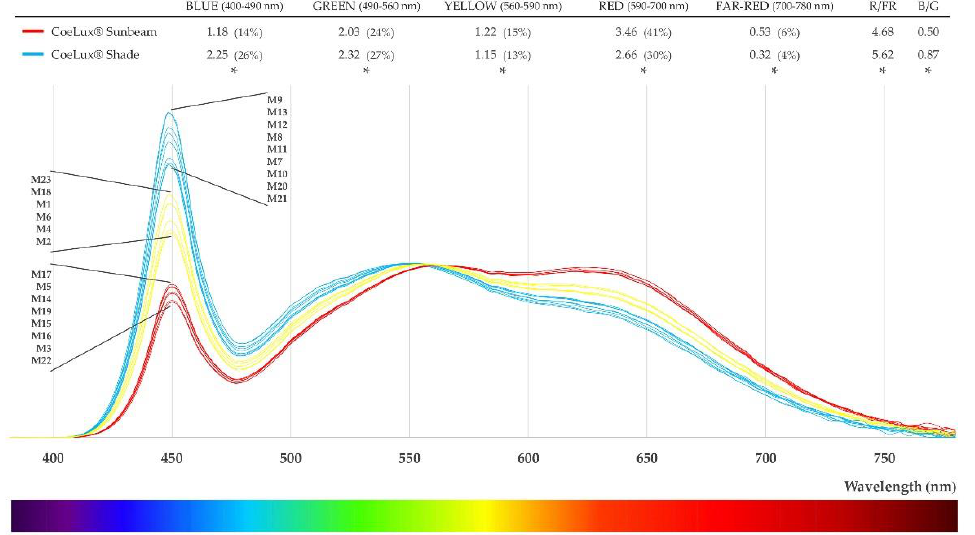
Figure 8. Light spectra measured within the sunbeam (red lines), in shade areas (light blue lines), and in frontier positions between sun and shade (yellow lines). Measurements (M) are reported in order of appearance in the graph. Color components mean values are reported and statistically significant differences are marked with an asterisk (*). R/FR: red/far-red ratio; B/G: blue/green ratio.